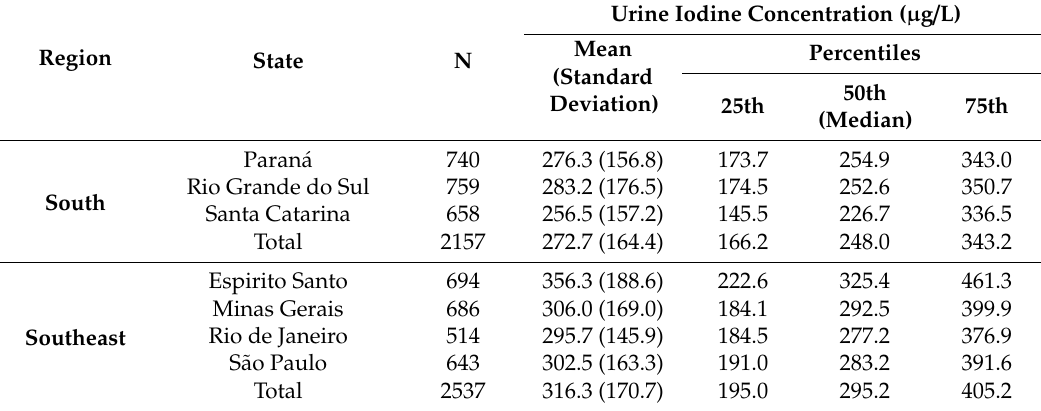
Table 3. Standard deviation and median urine iodine concentration for schoolchildren aged 6 to 14 years by region and states, Brazil,